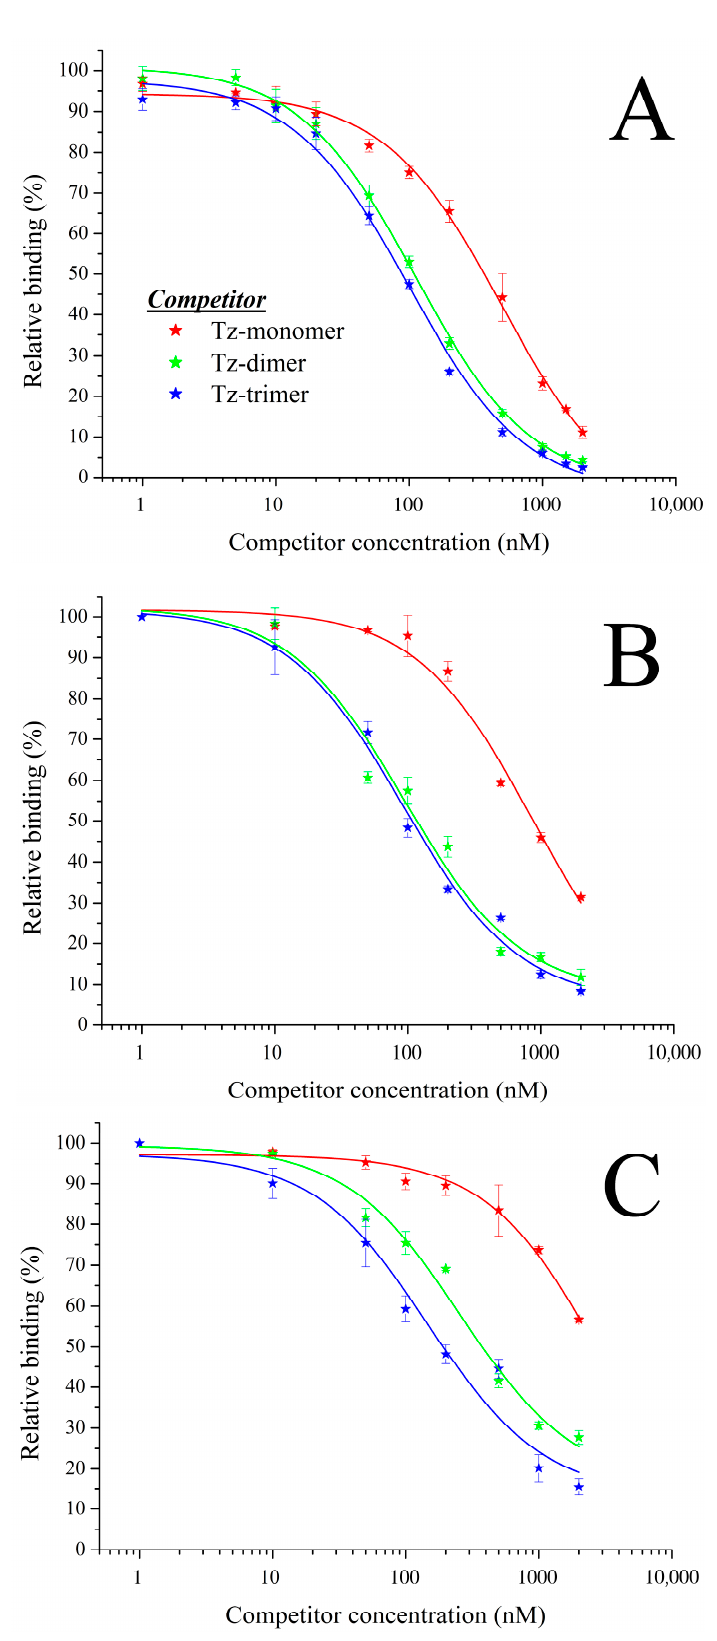
Figure 1. Competitive binding studies of [ 68 Ga]Ga-Tz-monomer ( A ), [ 68 Ga]Ga-Tz-dimer ( B ) and [ 68 Ga]Ga-Tz-trimer ( C ) on immobilized RTX-TCO using the non-labelled counterparts as competitor.